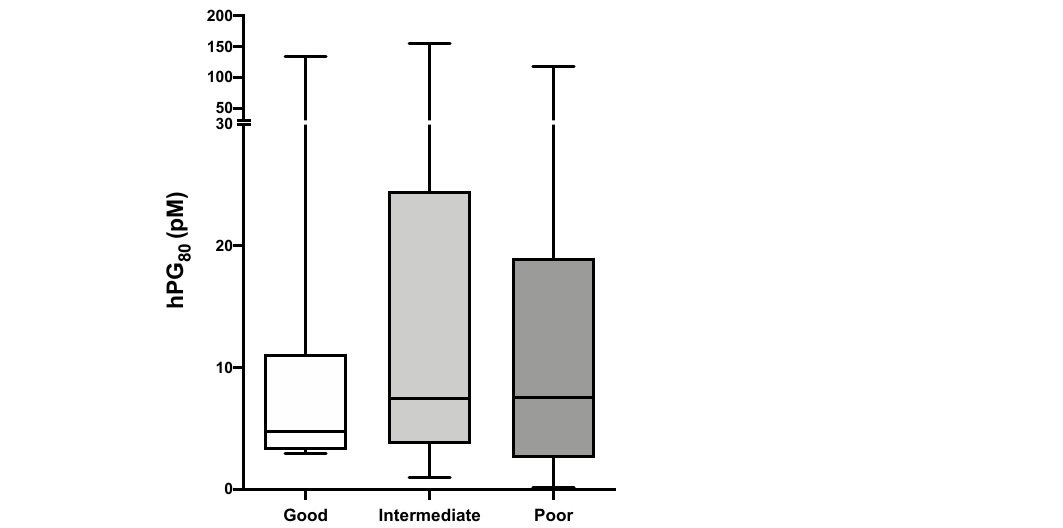
8 of 14 Table 3. hPG 80 levels according to the IMDC score in mRCC patients. Characteristics